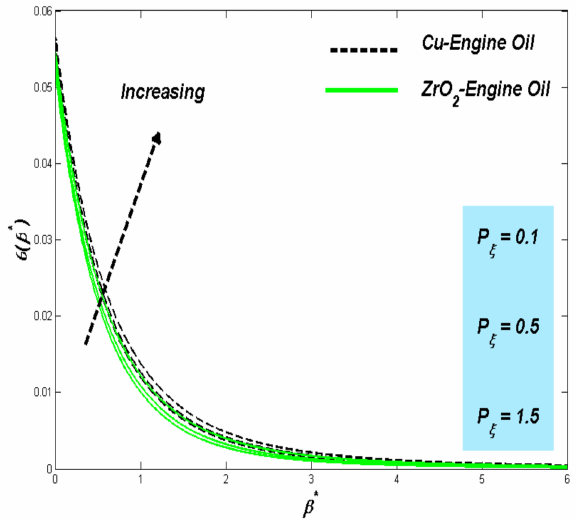
Figure 15. Temperature profile change with P ξ